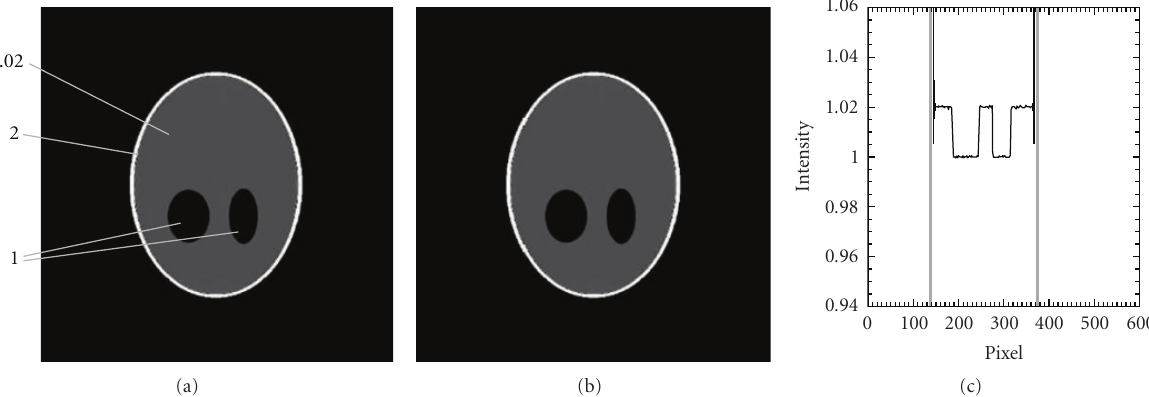
Figure 7: Shepp-Logan phantom reconstruction (middle slice): (a) is the true image, and (v) is the reconstruction by use of GPU-accelerated FDK program, (c) is a line profile along y = 200pixel. The dotted line corresponds to GPU reconstructed image profile and the solid line corresponds to the true phantom profile. Little di ff erence is shown in the line profiles.